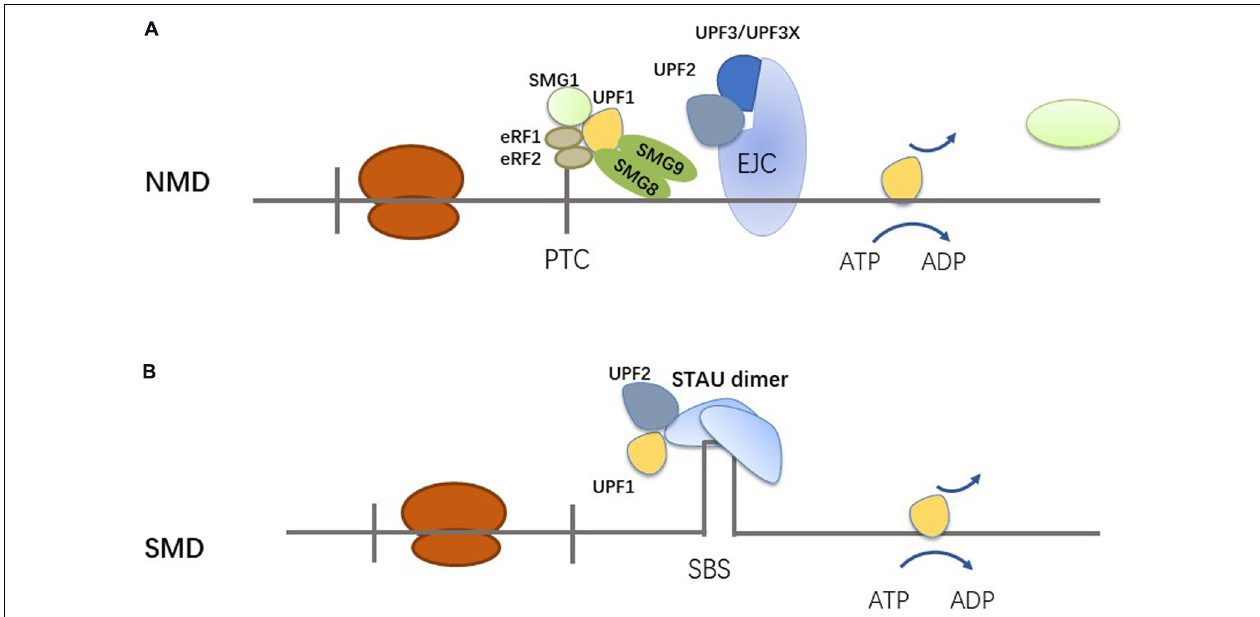
FIGURE 2 | Mechanisms of NMD and SMD. (A) UPF1 is engaged in NMD via binding PTC through the translation termination complex. (B) UPF1 is engaged in the SMD via 3 (cid:48) UTR-bound STAU1 or